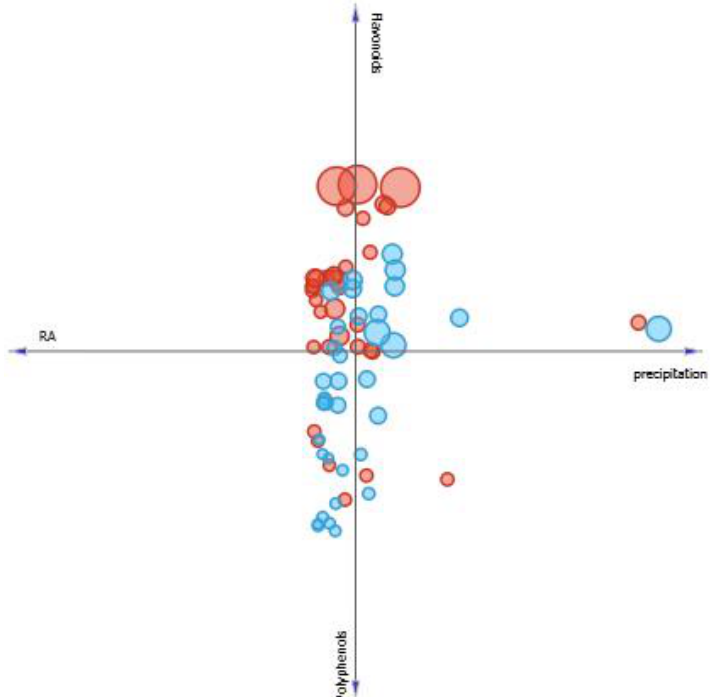
Figure 11. Linear projection correlating the content of phenolics, flavonoids, and rosmarinic acid of M. villosa (blue circles) and P. amboinicus (red circles) to precipitation. Circles size corresponds to a greater or lesser EC 50 value found.